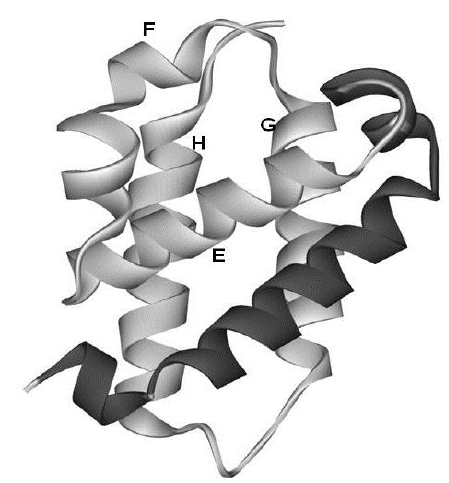
Figure 3. 3D structure of 2-on-2 hemoglobin, i.e., Mycobacterium tuberculosis hemoglobin (PDB: 1NGK). The portion in light gray is the E-to-H helix unit. The E-to-H helix unit of this protein is very similar to that in 1FSL or